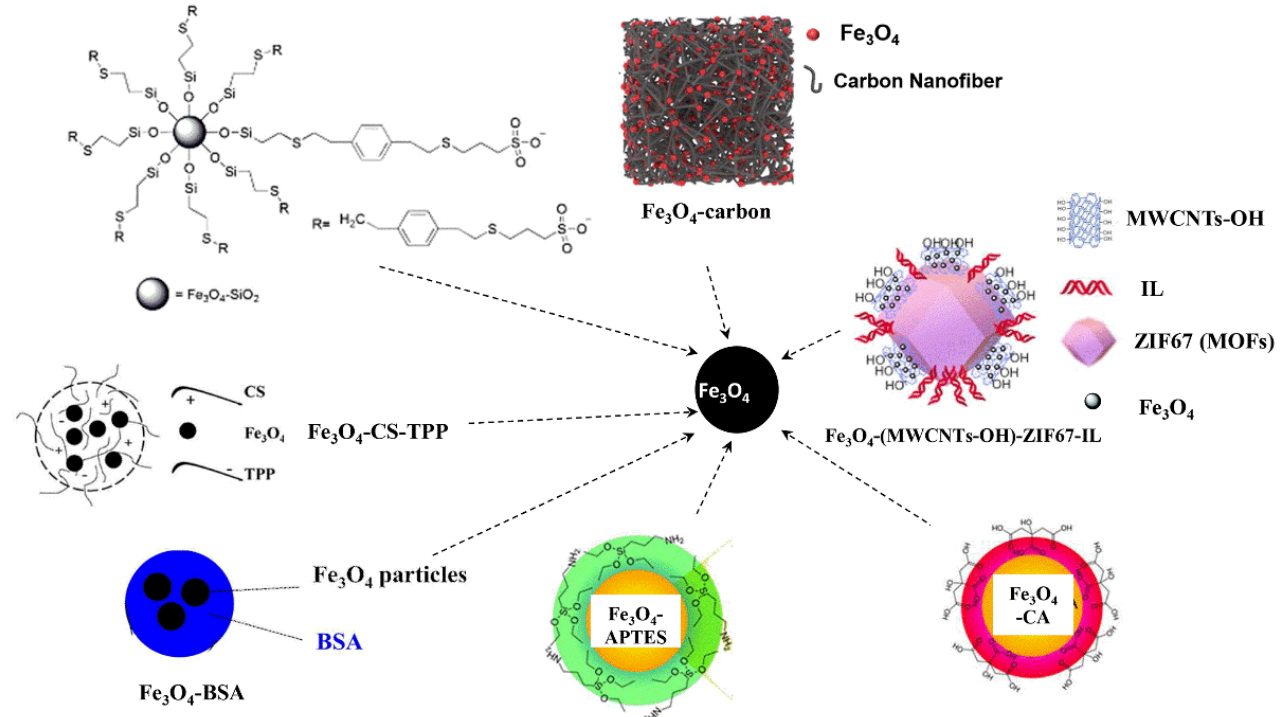
Figure 3. The structures of several representative magnetic materials [55 – 59].